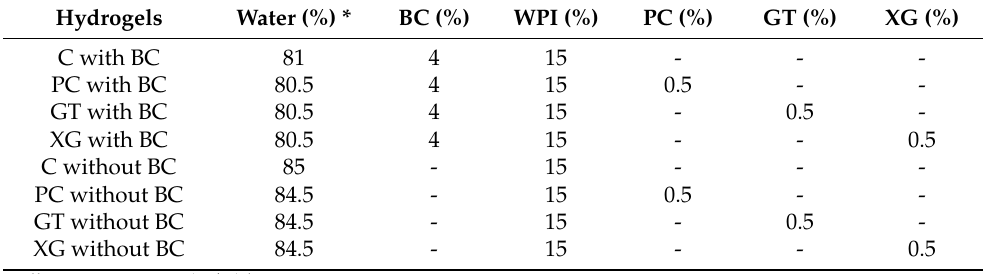
Table 1. Formulations of hydrogels in the presence and absence of BC. (“C”, “PC”, “GT” and “XG” denote control, pectin, gum tragacanth and xanthan gum, respectively).